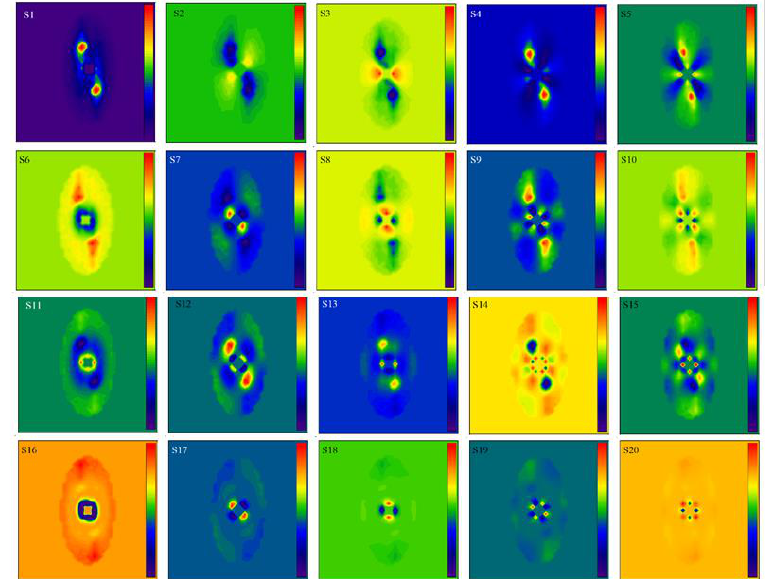
Figure 3. 20 orthogonal spectral components of the VV case in Figure 2d.